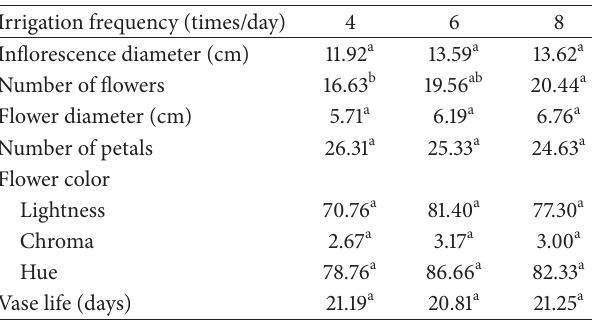
Table 10: Effect of irrigation frequencies on flowering characteris- tics of